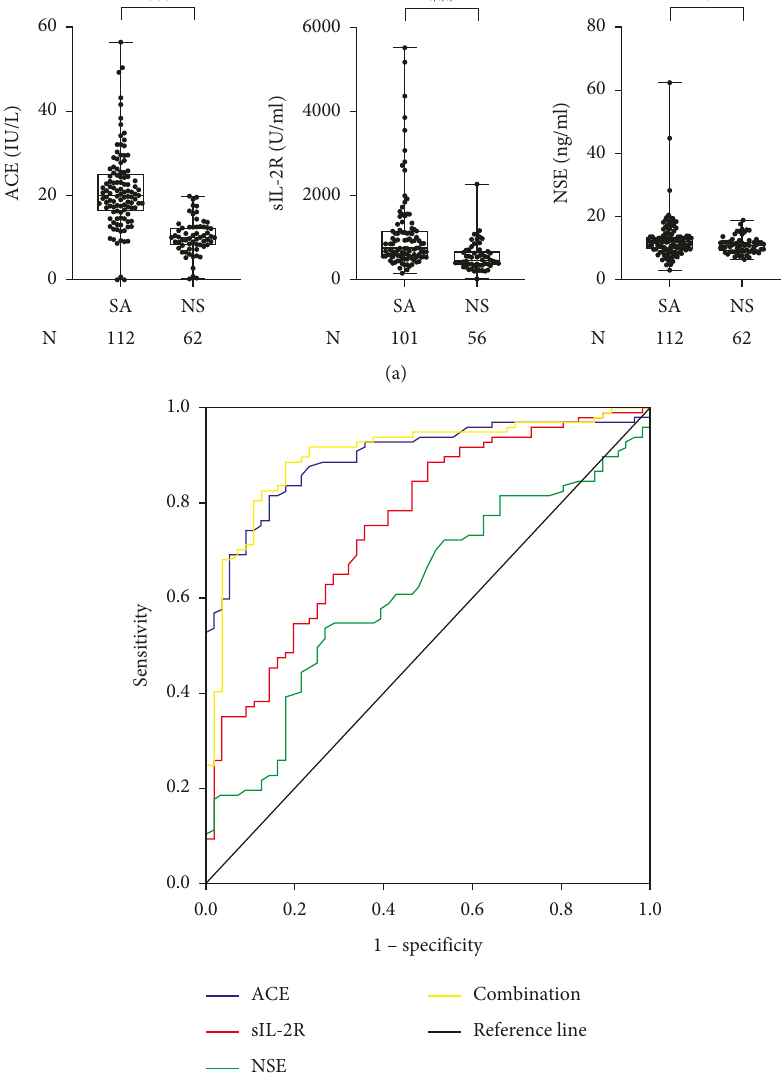
Figure 2: (a) Comparisons of serum levels of NSE, sIL-2R, and ACE in patients with sarcoidosis (SA) versus nonsarcoidotic benign diseases (NS). The box extends from the 25 th to 75 th percentiles with the line in the middle of the box indicating the median level. The whisker represents the minimum level to the maximum level. (b) Receiver operating characteristic (ROC) curves for NSE, ACE, sIL-2R, and their combination in patients with sarcoidosis. ∗ P < 0 . 05; ∗∗∗ P < 0 .